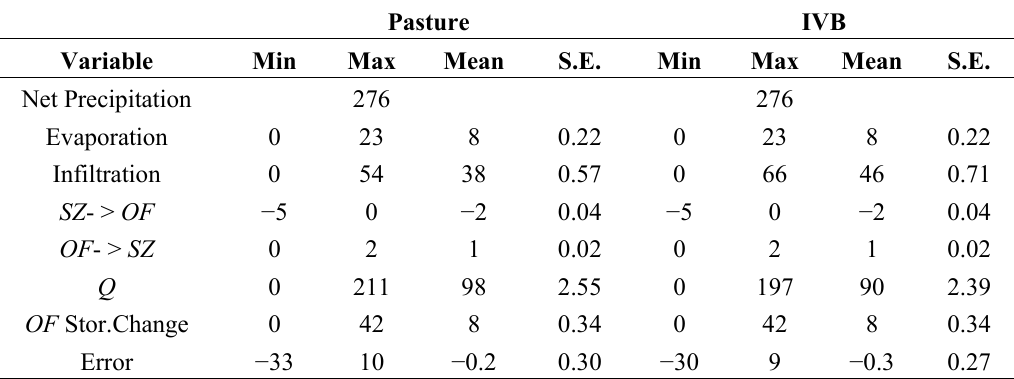
Table 3. Summary of water balances for pasture and IVB simulations (mm). SZ = saturated zone; OF = overland flow; Q = discharge (boundary